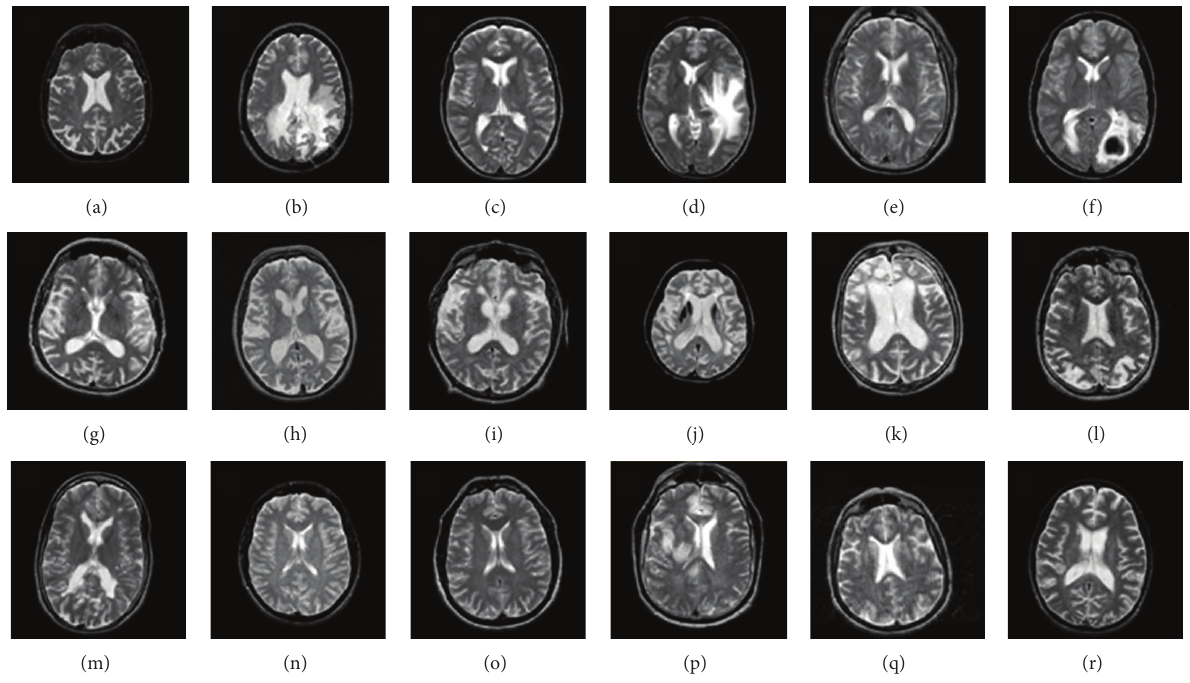
Figure 6: Sample of brain MRIs: (a) normal brain; (b) glioma, (c) metastatic adenocarcinoma; (d) metastatic bronchogenic carcinoma; (e) meningioma;(f)sarcoma;(g)Alzheimer;(h)Huntington;(i)motorneurondisease;(j)cerebralcalcinosis;(k)Pick’sdisease;(l)Alzheimerplus visual agnosia; (m) multiple sclerosis; (n) AIDS dementia; (o) Lyme encephalopathy; (p) herpes encephalitis; (q) Creutzfeld-Jakob disease; and (r) cerebral